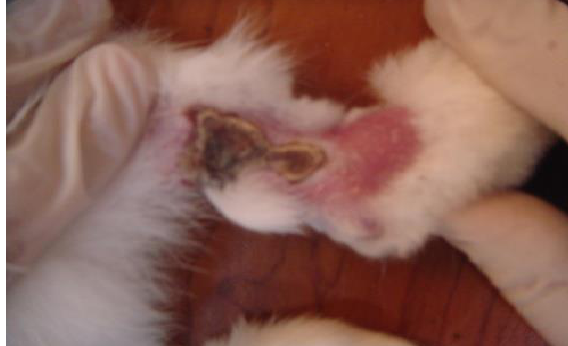
Fig, 1: The ankle join in the non-immunized rabbit, 30 day post inoculation showed: swelling, redness and a sinus which drained